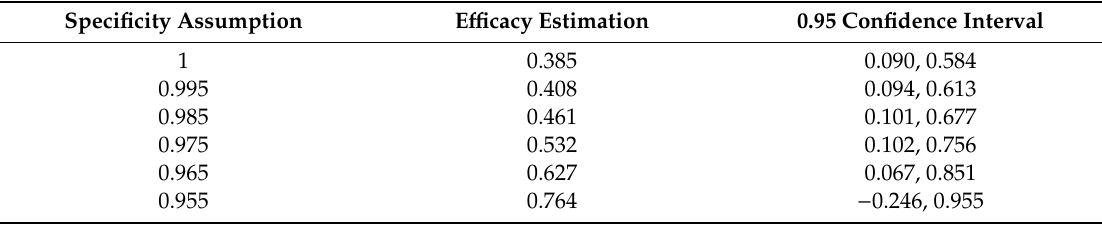
Table 1. HIV prevention e ffi cacy estimates depending on specificity assumptions using Equations (7) and